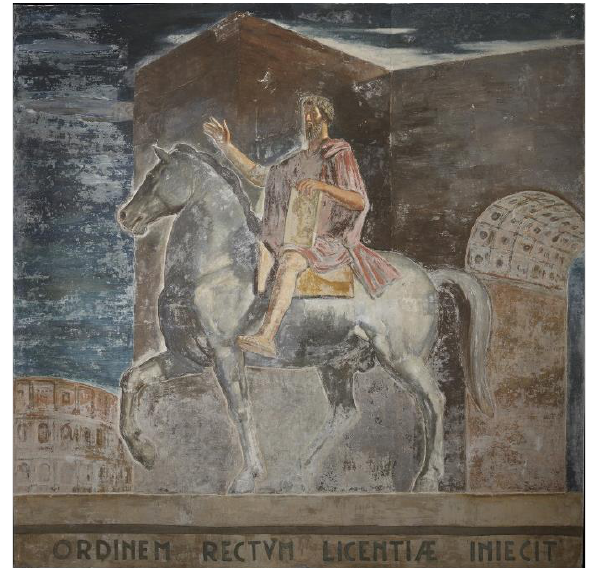
Fig 2. Ottavio Steffenini, Marco Aurelio a cavallo , 1937, 4,80x4,90 m, before restoration as described in Siena (2017).